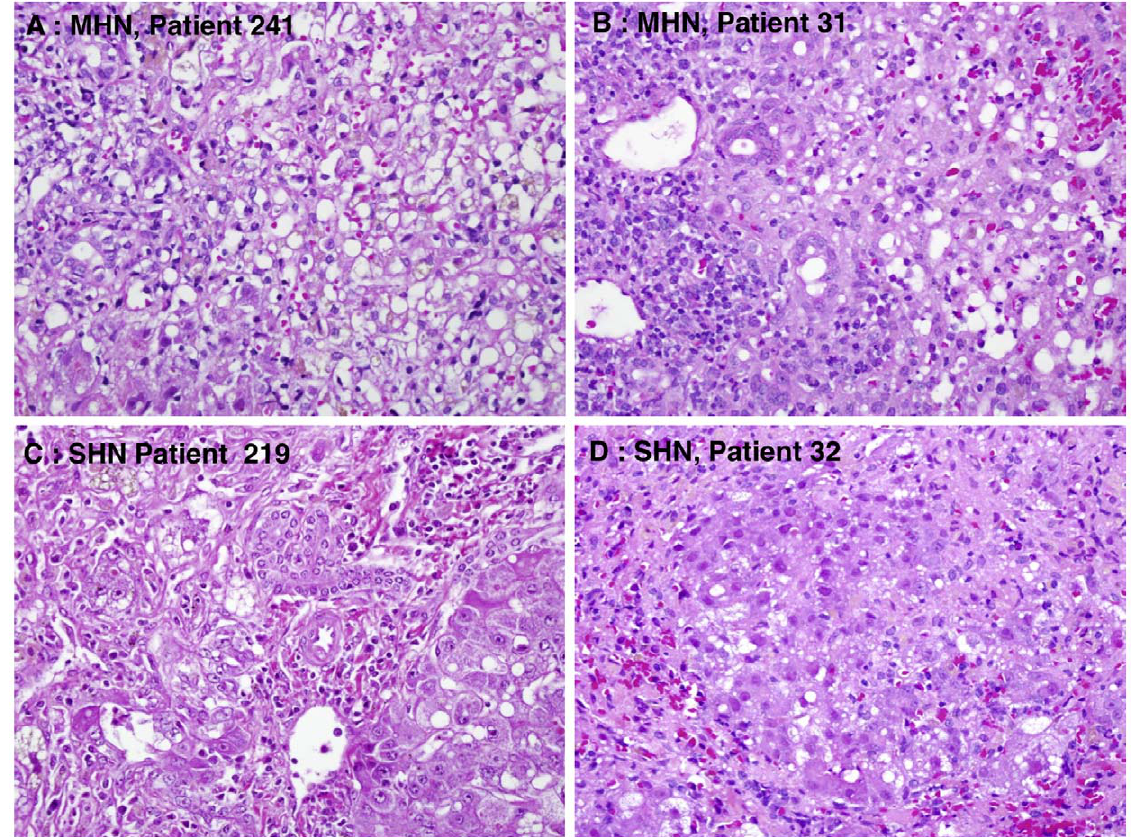
Figure 1. Histopathologic features of HBV-associated acute liver failure (ALF) showing the severity of hepatic necrosis in 4 patients. At the time of liver transplantation there was massive hepatic necrosis (MHN) with no viable hepatocytes in Patient 241, MHN (nearly 100%) with few scattered hepatocytes in Patient 31, and submassive hepatic necrosis (SHN) in Patients 219 (70 to 80% necrosis) and 32 (60% necrosis) (hematoxylin and eosin, x400).